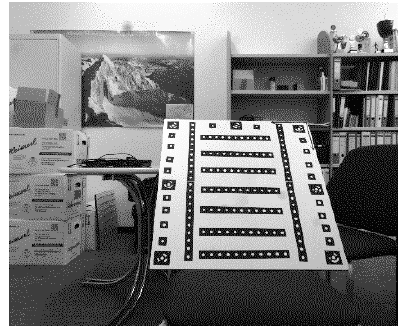
Figure 5. Image of the left industrial camera showing the calibration pattern without looking through the windshield.